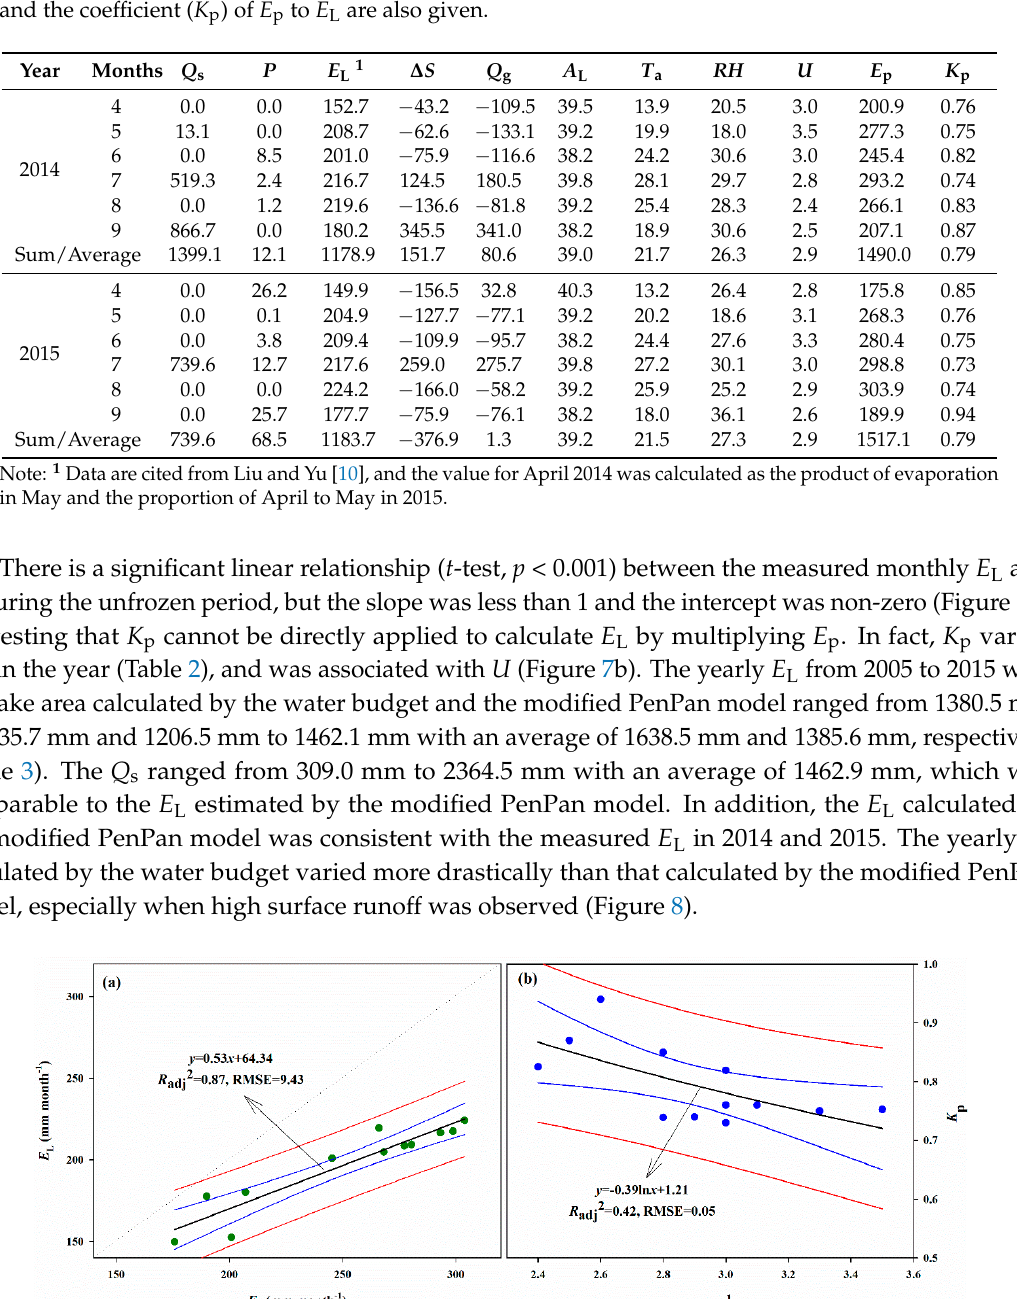
Table 2. The water budget of Juyan Lake and corresponding lake and meteorological conditions during the unfrozen period in 2014 and 2015. The surface runoff ( Q s , mm), precipitation ( P , mm), lake evaporation ( E L , mm), and water storage change ( Δ S , mm) were directly measured and ground runoff ( Q g , mm) was calculated as a residue of the water budget. Mean of lake area ( A L , km 2 ), air temperature ( T a , ◦ C), relative humidity ( RH , %), wind speed ( U , m · s − 1 ), pan evaporation ( E p , mm), and the coefficient ( K p ) of E p to E L are also given.